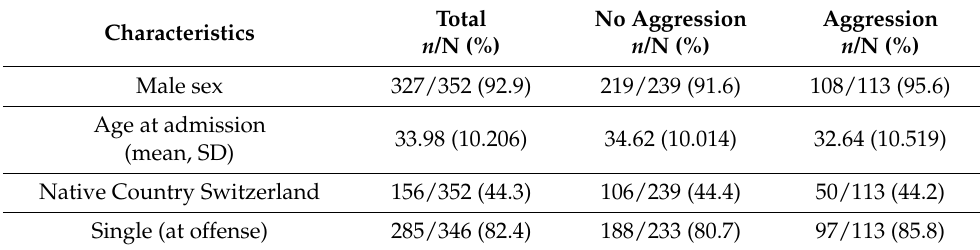
Table 1. Sociodemographic characteristics 1 .